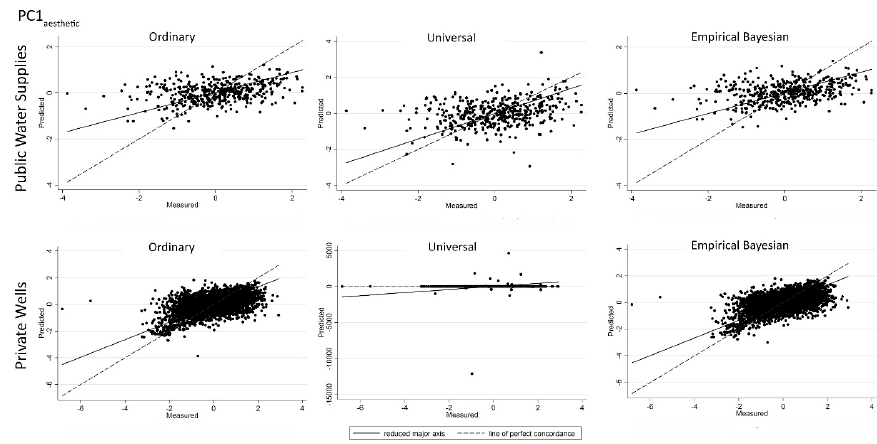
Figure A5. Predicted vs. measured values for PC1 aesthetic scores obtained from the cross-validation results for ordinary, universal, and empirical Bayesian kriging for: public water supplies ( top row ); and private wells ( bottom row ). Line of perfect concordance indicated by dashed line.